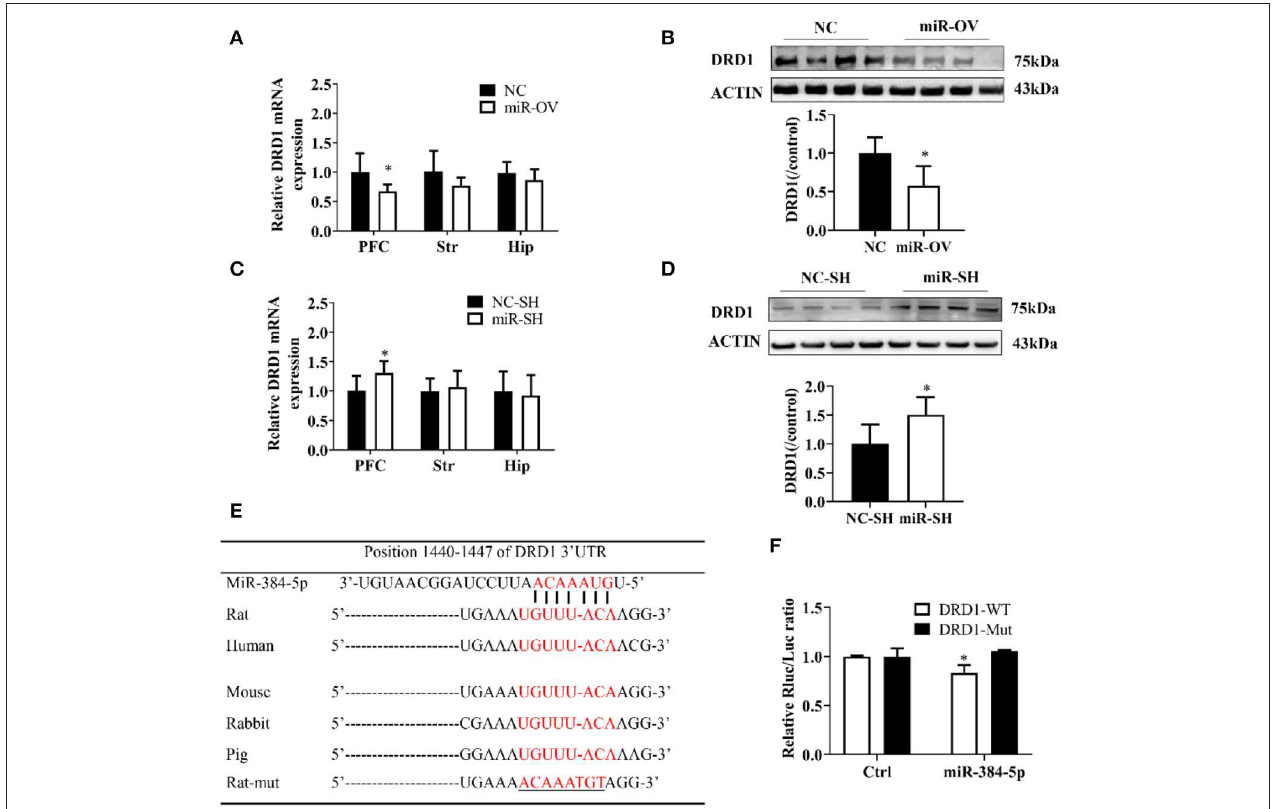
FIGURE 4 | miR-384-5p up- or down-regulation alters DRD1 expression levels. (A,B) Relative expression levels of DRD1 mRNA in different brain areas (A) , and DRD1 protein level in the PFC (B) , as a result of miR-384-5p overexpression. (C,D) Relative expression levels of DRD1 mRNA in different brain areas (C) and DRD1 protein level in the PFC (D) , following suppression of miR-384-5p. (E) Complementarity between miR-384-5p seed sequence and 3 ′ UTR of DRD1 mRNA, as predicted by TargetScan. (F) Relative luciferase activity in HEK-293T cells co-transfected with miR-384-5p or control vector and DRD1-WT or DRD1-Mut. * P < 0.05.